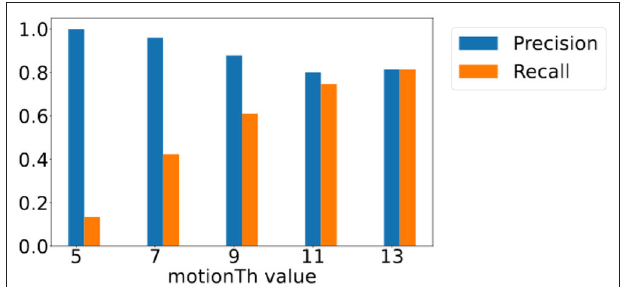
FIGURE 10 | Precision and recall score for footsteps closer than 8 ft away from camera with different motionTh values.